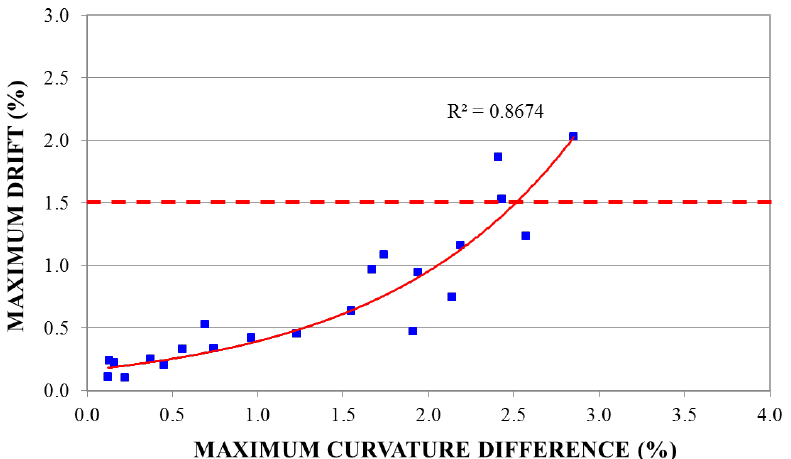
Figure 15. Structural damage quantification: empirical correlation between the maximum inter-story drift and the maximum curvature difference for the 5-story building.